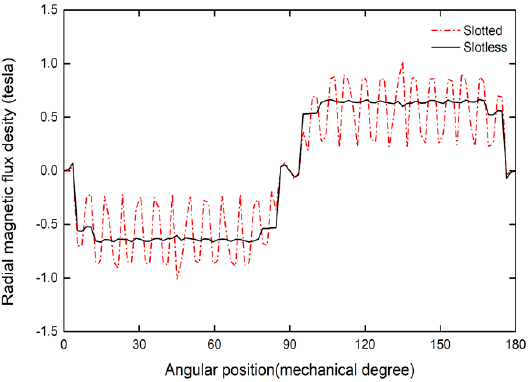
Figure 2. Waveform of the radial component of the airgap flux density at no − load. Fourier decomposition of the airgap magnetic flux density is used to calculate the amplitude of each order at no-load. Figure 3 shows the FFT of Figure 2, the reduction in the amplitude of the magnetic field of the fundamental wave for the slotted model. Additional harmonic orders of the magnetic field can be observed. The harmonic orders of the flux density for the slotted motor can be determined using the following equation [20]: